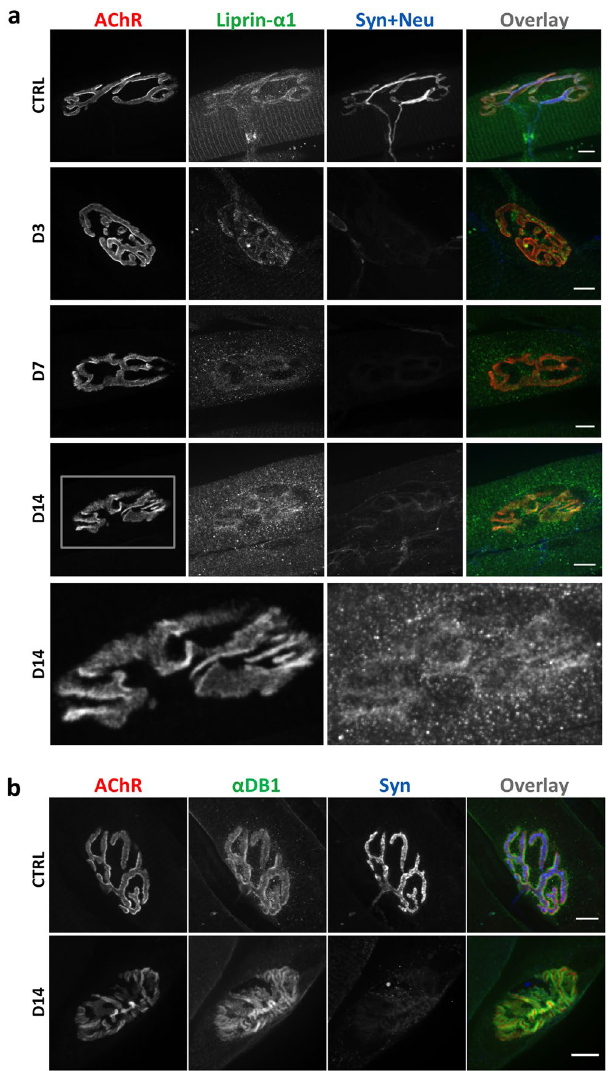
Figure 3. Liprin- α -1 NMJ localization is nerve-dependent. Fibers were isolated from the tibialis anterior muscle from P30 mice on the indicated days after the nerve cut procedure. ( a ) Liprin- α -1 (green) localisation at different days after nerve cut. The bottom panel represents higher magnification of the box in the upper panel (D14). ( b ) α -dystrobrevin-1 immunostaining (green) 14 days after nerve cut. AChR are visualized with BTX in red and anti-synaptophysin/anti-neurofilament immunostaining is shown in blue. All of the images were collected using the same exposure and imaging parameters. Scale bar 10 μ